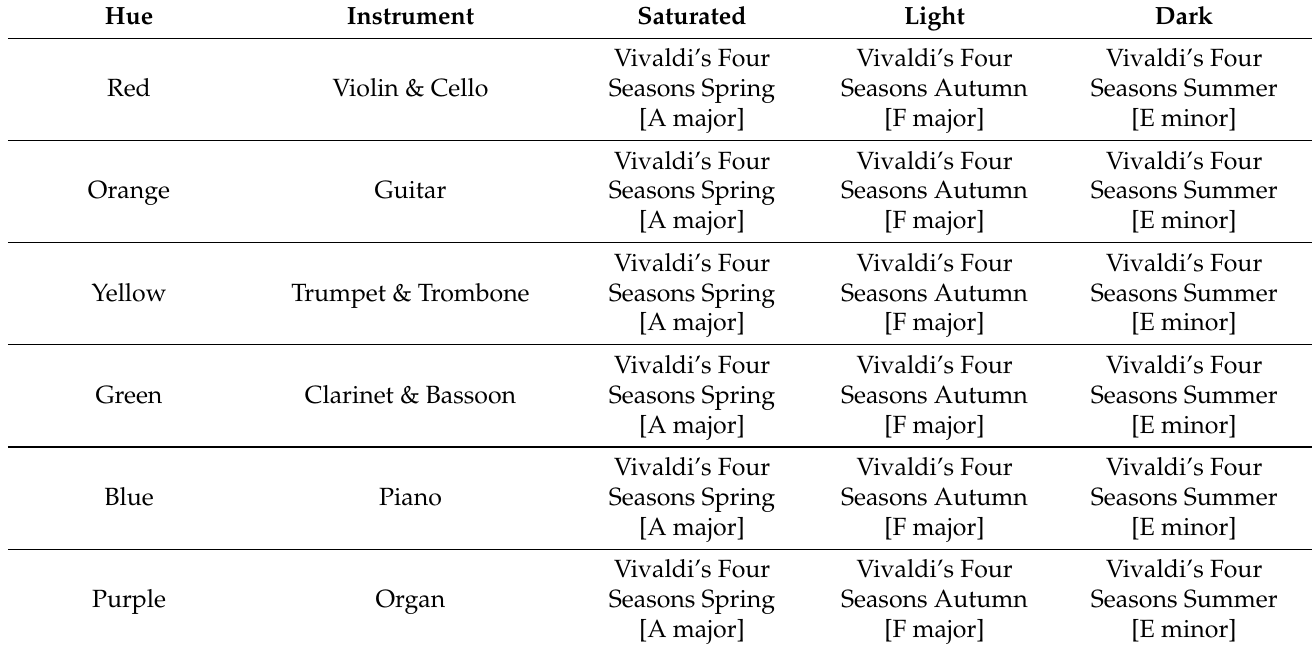
Table 6. VIVALDI Sound Color